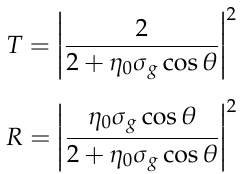
Figure 2. The real ( a ) and imaginary part ( b ) of σ g as functions of µ c and λ